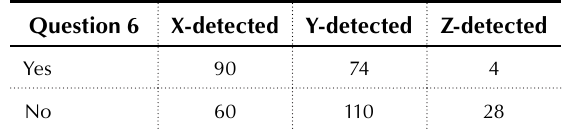
Table 11. The obtained data